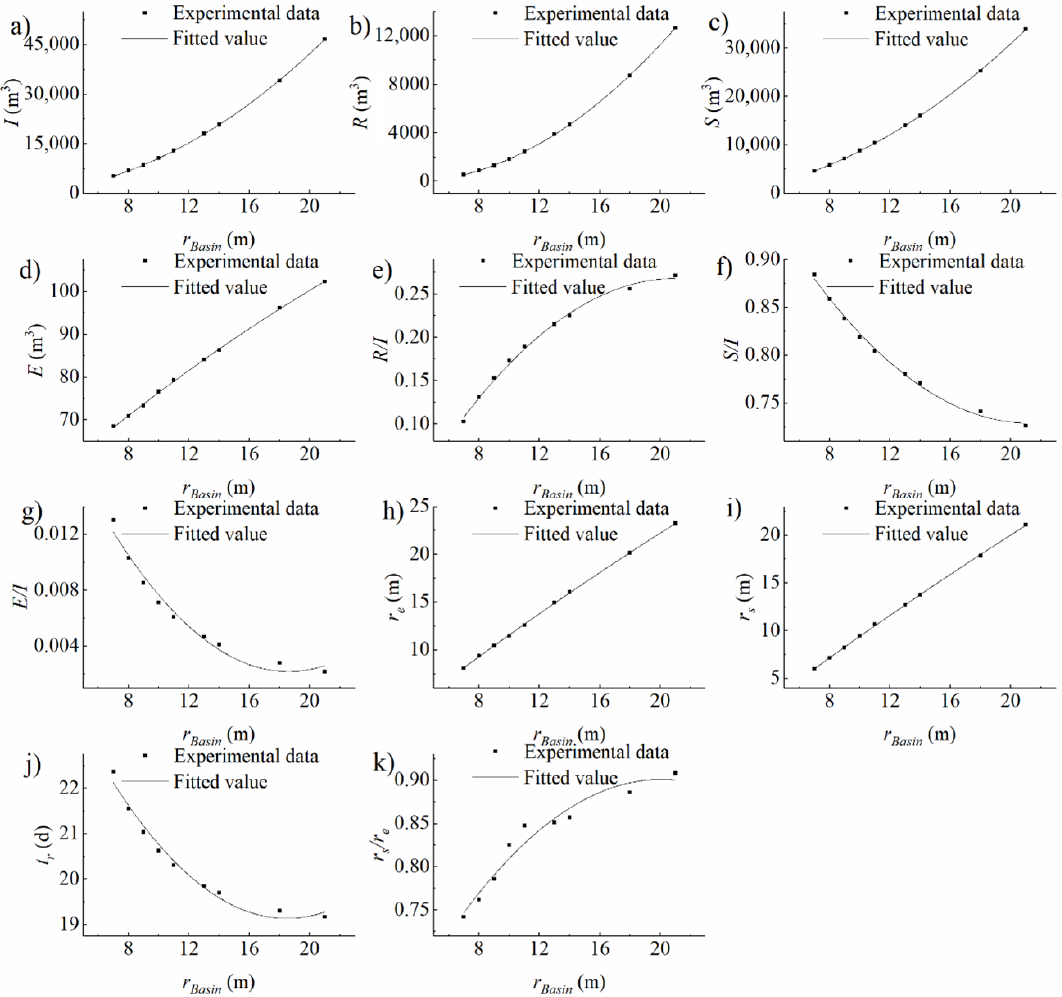
Figure 3. The variations with an increment in r Basin . (( a ) variation of I; ( b ) variation of R; ( c ) variation of S; ( d ) variation of E; ( e ) variation of R/I; ( f ) variation of S/I; ( g ) variation of E/I; ( h ) variation of r e ; ( i ) variation of r s ; ( j ) variation of t r ; ( k ) variation of r s /r e .).